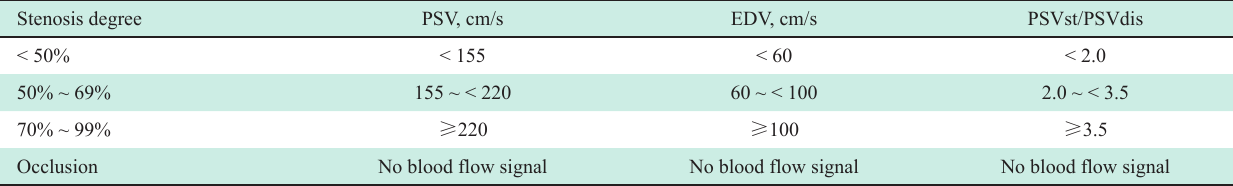
Table 3 Diagnostic criteria of blood flow parameters for the vertebral artery stenosis (2009, Xuanwu Hospital, Capital Medical University) Stenosis degree PSV, cm/s EDV, cm/s < 50%